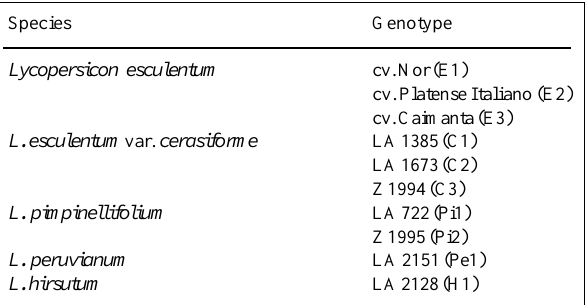
Table I - Genotypes of Lycopersicon investigated.